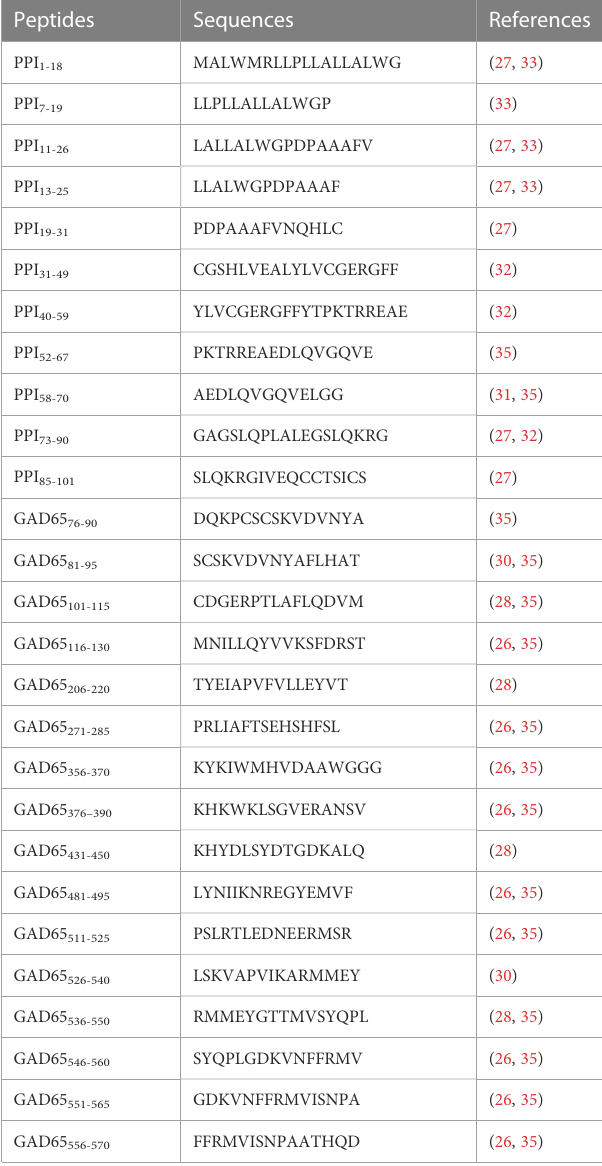
TABLE 2 PPI and GAD65 immunodominant epitopes identi fi ed in different HLA transgenic mice and humans used in this work.